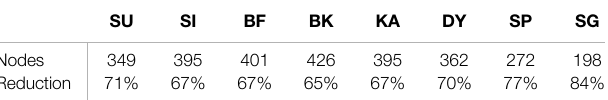
TABLE 4 | Graph size for the 1-2-3-4 – 5-6 multi-session map for each visual feature used and the percentage of nodes removed in comparison with